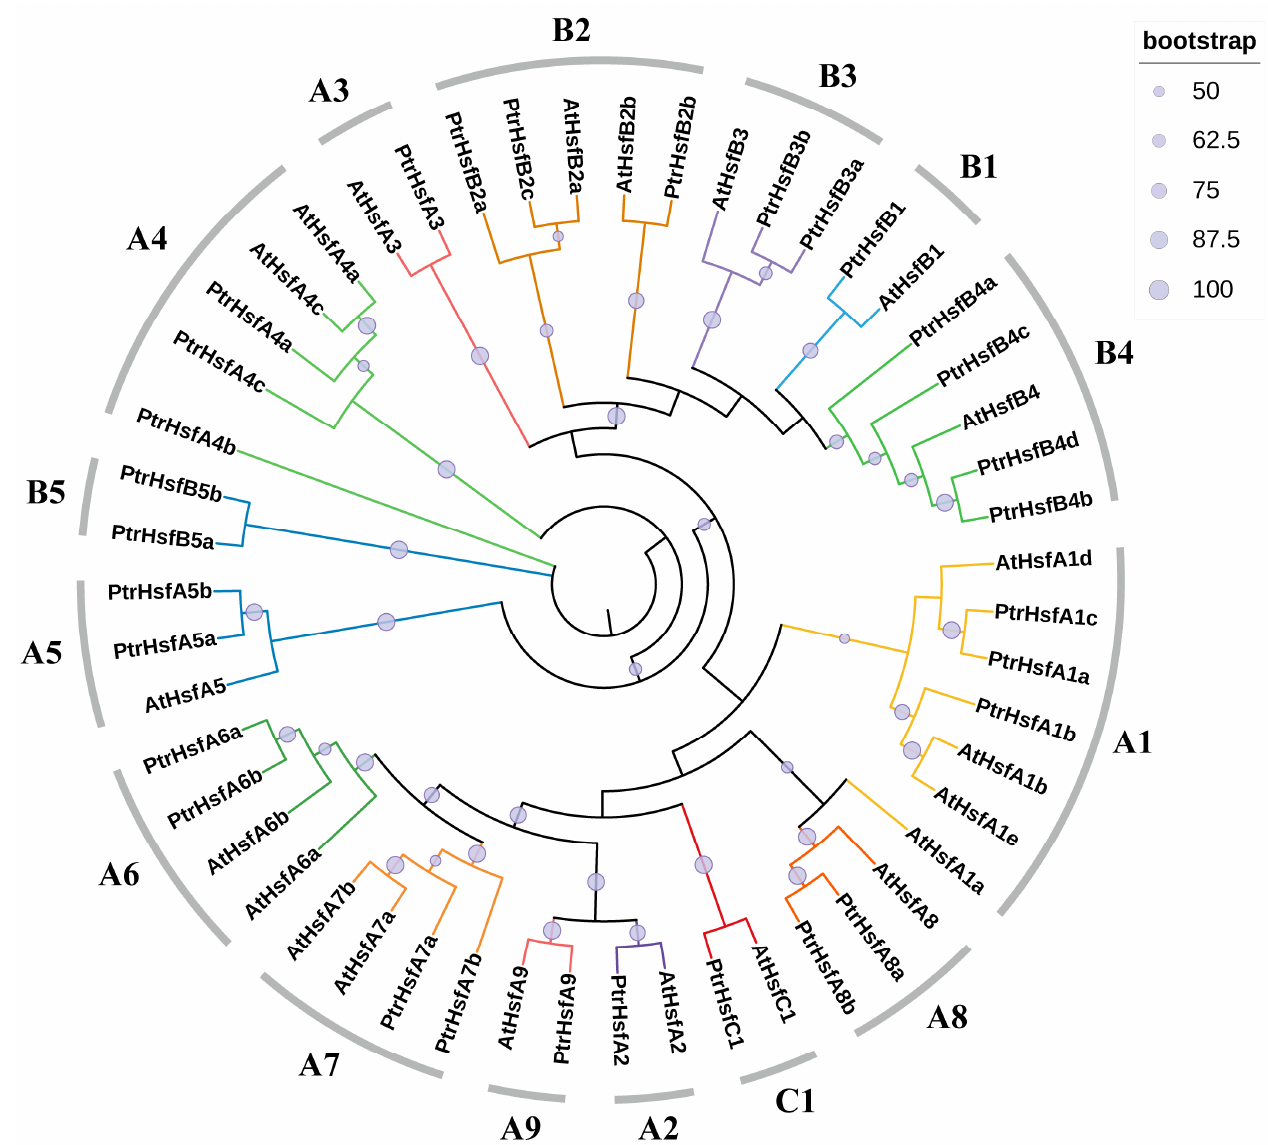
Figure 2. Dendrogram of poplar and Arabidopsis HSF proteins. The dendrogram was constructed using TBtools with the maximum likelihood method and 1000 bootstrap tests. Each class of proteins is marked by a specific color.